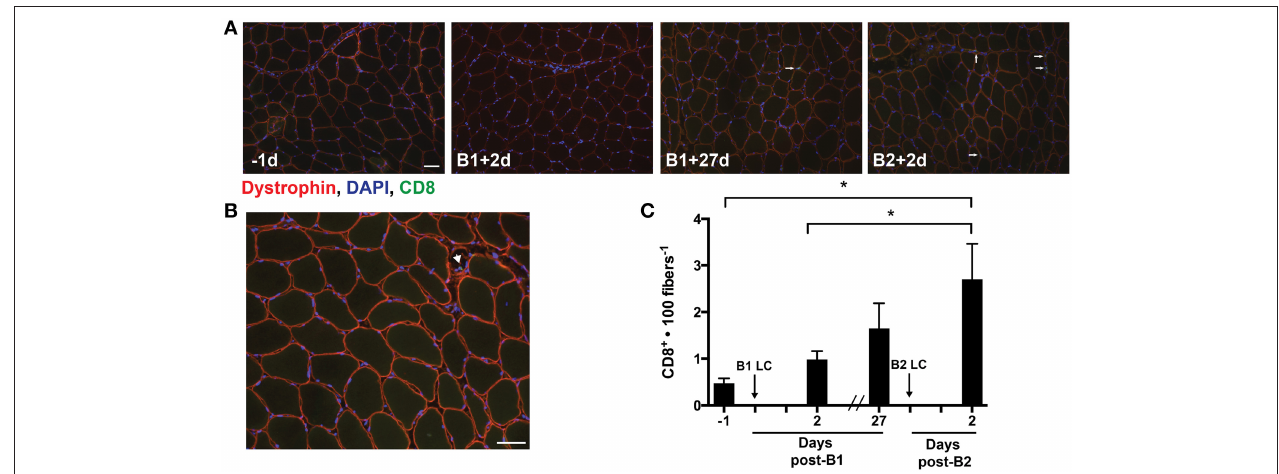
FIGURE 4 | Muscle-infiltrating CD8 + T-cells. (A) Eight micrometer thick sections stained for dystrophin (red), DNA (blue), and CD8 (green). All four images were taken from muscle samples 1 day before bout 1 (B1) of damaging lengthening contractions (LC) ( − 1d), 2 days after B1 (B1 + 2d), 27 days after bout 1 (B1 + 27d) and two days after bout 2 (B2) (B2 + 2d). The arrows show a CD8 + T-cell as evidenced by CD8 immunoreactivity localized around a DAPI-positive nucleus. (B) Merged image reveals the CD8 + T-cell invading an apparently necrotic fiber. (C) CD8 + T-cell enumeration per muscle fiber before and 2 days following the first (B1) and second bout (B2) of damaging lengthening contractions (LC). * Indicates significant difference (One-way repeated measures ANOVA with Tukey’s HSD, p < 0.05 ). Scale bar = 50 µ